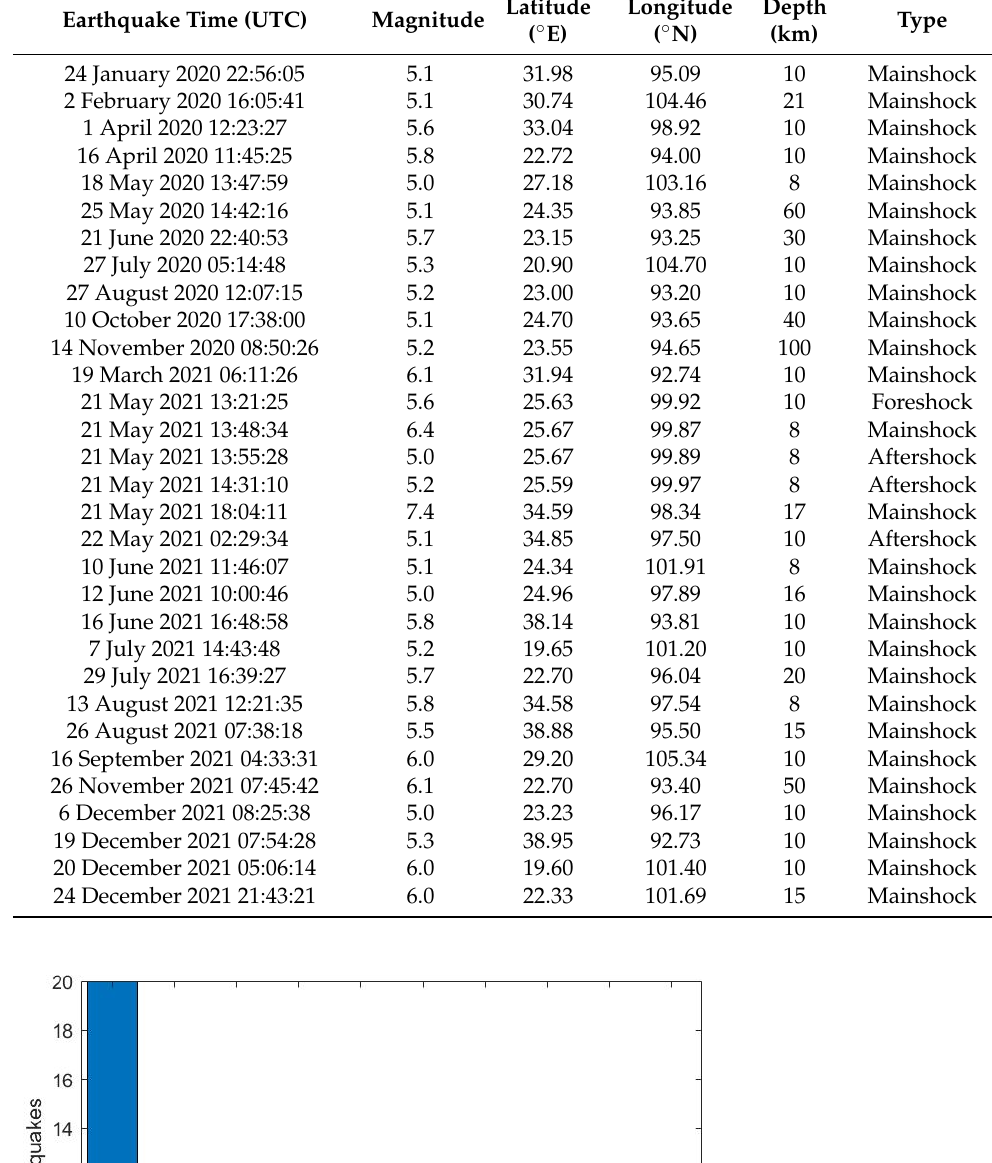
Table 1. The information list of the earthquakes occurred in the study area from 2020 to 2021.